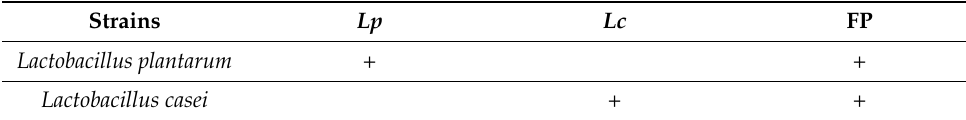
Table 1. Prunus mume juice (PJ) fermentation with lactic acid bacteria (LAB). Strains Lp Lc FP Lactobacillus plantarum + + Lactobacillus casei +